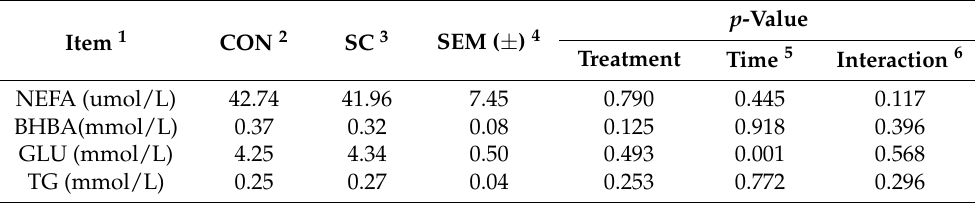
Figure 1. The effect of Saccharomyces cerevisiae culture (SC) on rumen VFA fermentation. SC is the experimental group diet supplemented with SC; CON is the control group without SC. ( a – f ) is the picture of pH, acetic, propionic, butyrate, total VFA concentrate, and acetate: propionate (A:P) with or without SC during the period, respectively. The data presented in the picture is mean ± standard error of mean. Table 4. Effects of SC on energy metabolism of high-yield lactating